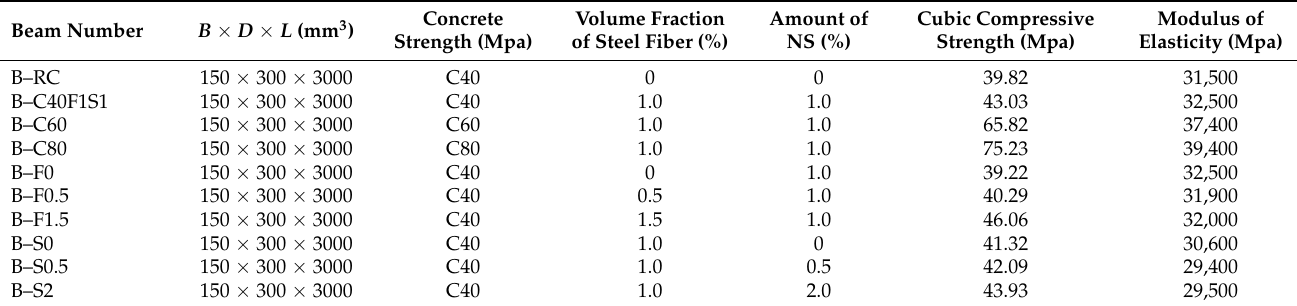
Table 1. Detailed parameters of the test specimens.